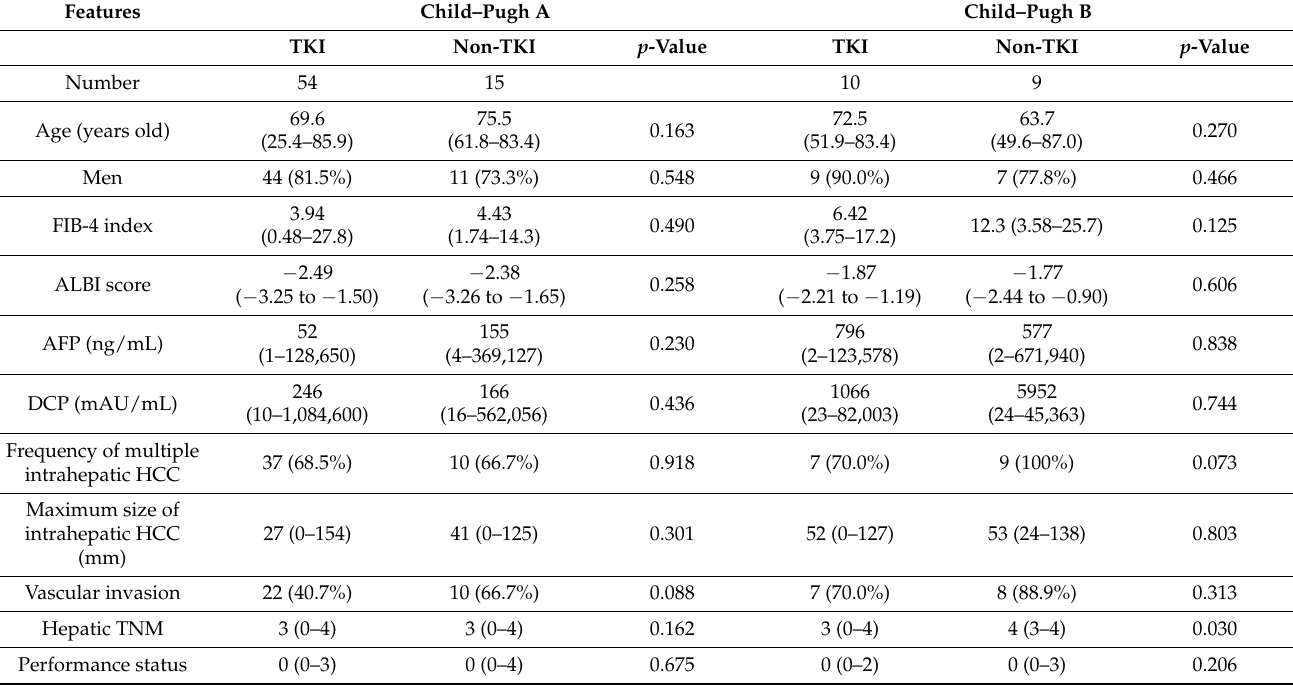
Table 2. Background data of patients in the TKI and non-TKI